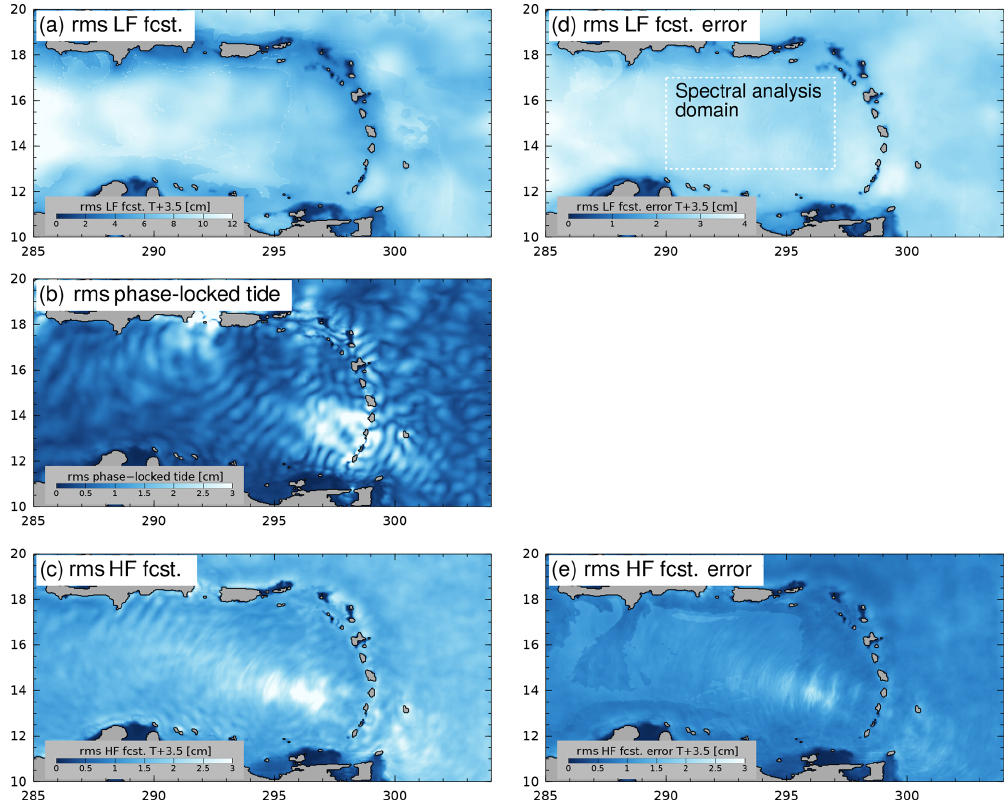
Figure 8. Root mean square (rms) quantities valid at T f + 3 . 5d (panel layout corresponds to snapshots in Fig. 5): (a) low-frequency forecast, (b) phase-locked tide forecast, and (c) high-frequency forecast; and the corresponding errors: (d) low-frequency forecast error and (e) high- frequency forecast error. Note the different color scales used for low-frequency variability. The “spectral analysis domain” in panel (d) indi- cates the region used for the computation of the radial wavenumber spectra in Fig. 10, below; it is also the region of spatial averaging for the forecast errors summarized in Fig.